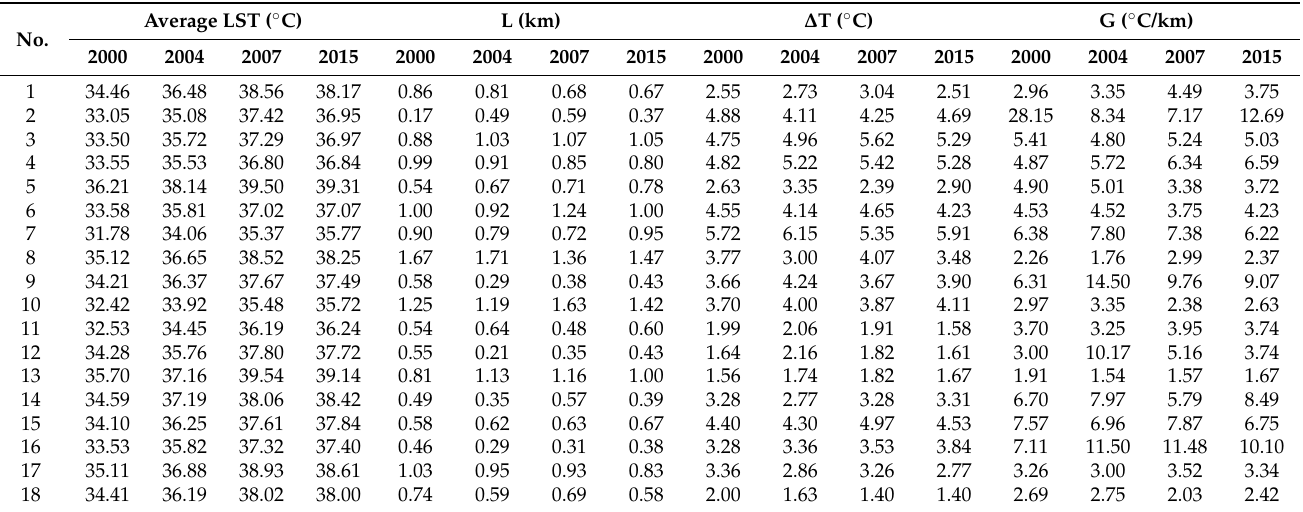
Figure 4. The LST retrieval results for Shanghai-based on Landsat data in the years 2000, 2004, 2007 and 2015. Table 4. Quantification results of WCI indicators.